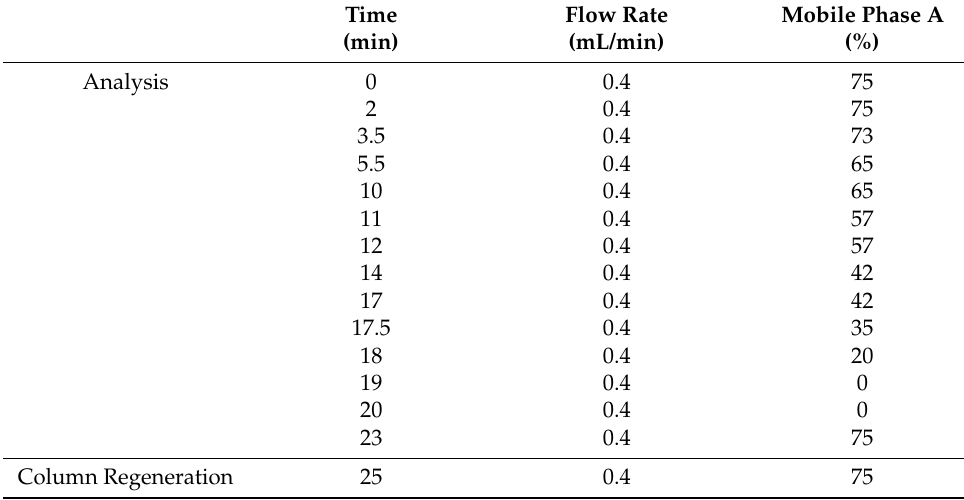
Table 6. LC-gradient for center